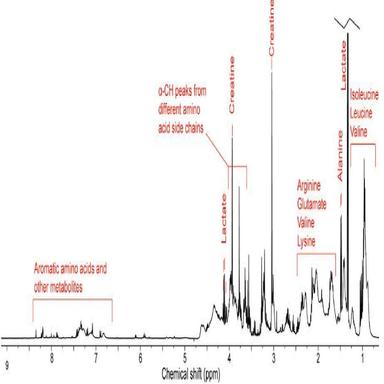
Representative 1 H NMR spectrum of chicken hydrolysate, hydrolysed with FoodPro PNL (0.1 % w/w) for 60 min. Assignments were done for the abundant peaks annotated in red, according to Ref.. Only peaks diagnostic to a given molecule were assigned. (For interpretation of the references to colour in this figure legend, the reader is referred to the Web version of this article.)